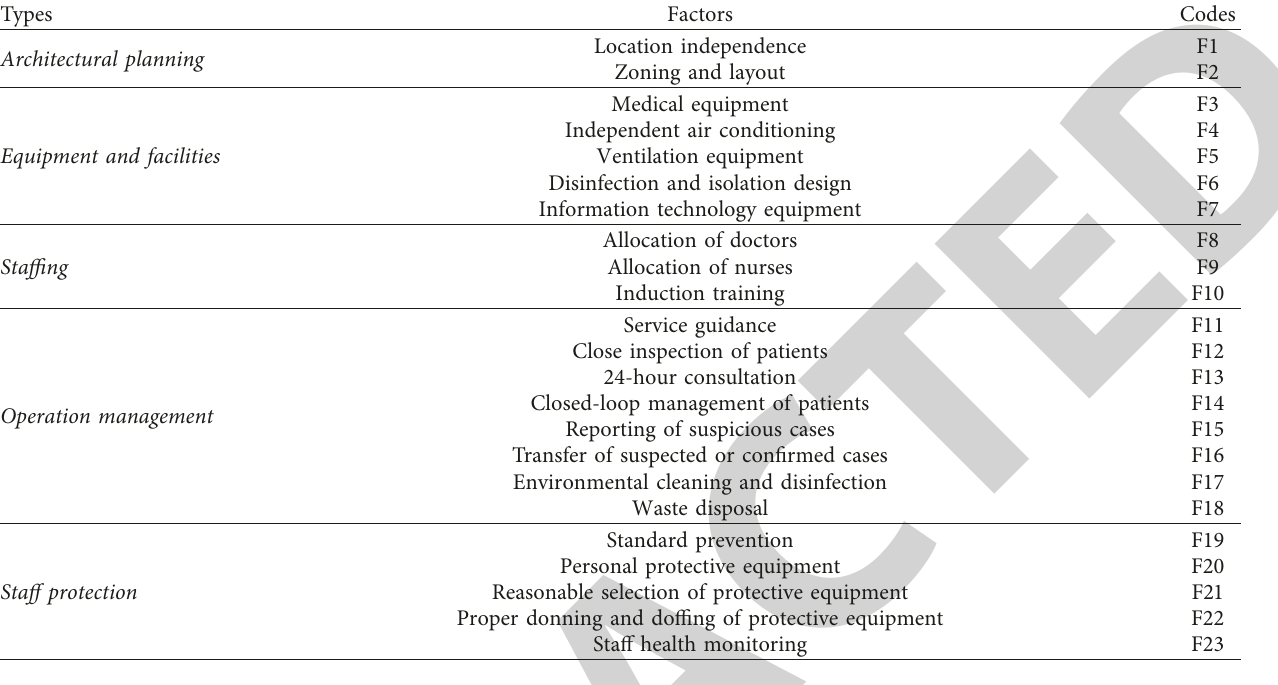
Table 1: Factors affecting the reliability of fever